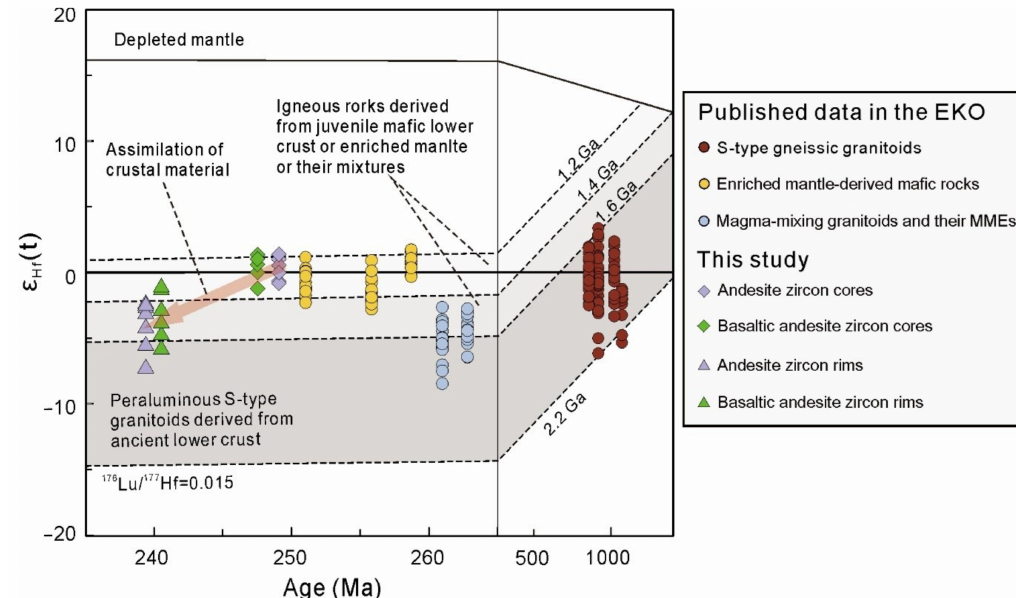
Figure 8. Plot of zircon ε Hf (t) vs. U-Pb age for the Nageng andesite and basaltic andesite. Data source: Peraluminous S-type gneissic granitoids from Refs. [63,64]; Magma-mixing granitoids and their Mafic micro-granular enclaves (MMEs) from Ref. [65]; Enriched Mantle-derived Mafic rocks from Refs.